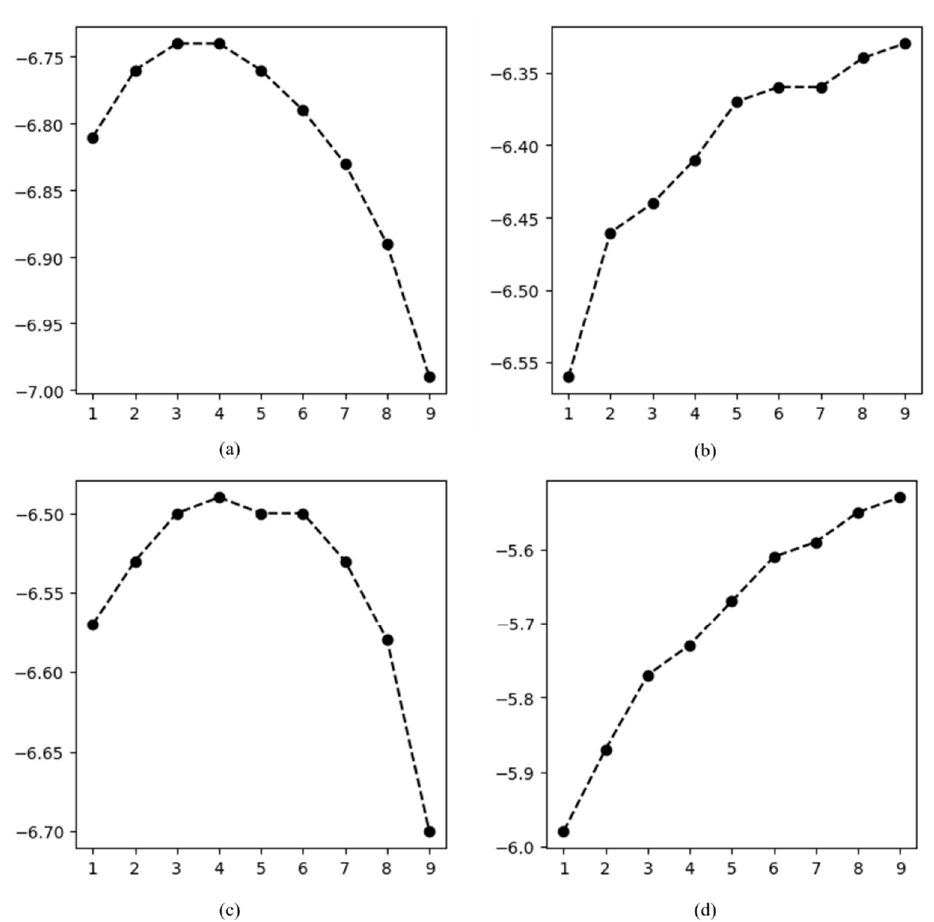
Figure 10. The perplexity graph for topic model ( a ) training set—inner set ( b ) training set—outlier set ( c ) testing set—inner set ( d ) testing set—outlier set.